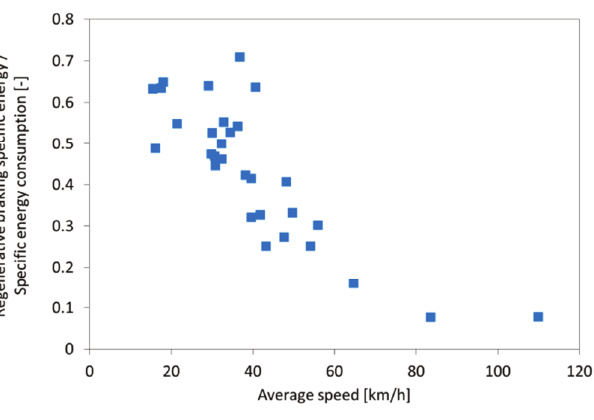
Fig. 2. Traffic conditions registered in urban and suburban area The share of the regenerative braking specific energy can be evaluated for selected mean operating parameters using speed pattern presented in Fig. 3. It has been assumed that the vehicle movement can be divided into three phases: acceleration, constant speed (cruising) and braking (decel- eration).